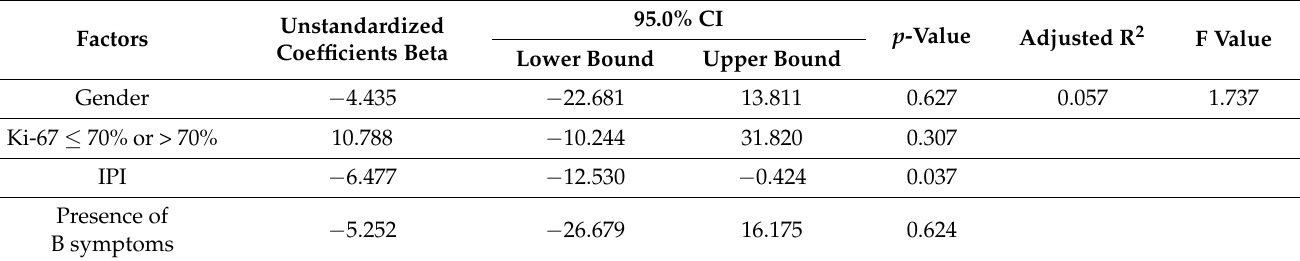
Table 3. Multivariate analysis of risk factors for overall